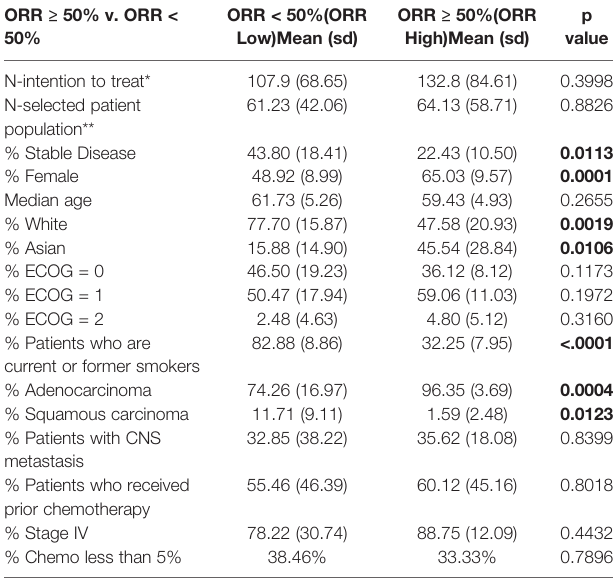
FDA Approved and Unapproved drug-indication